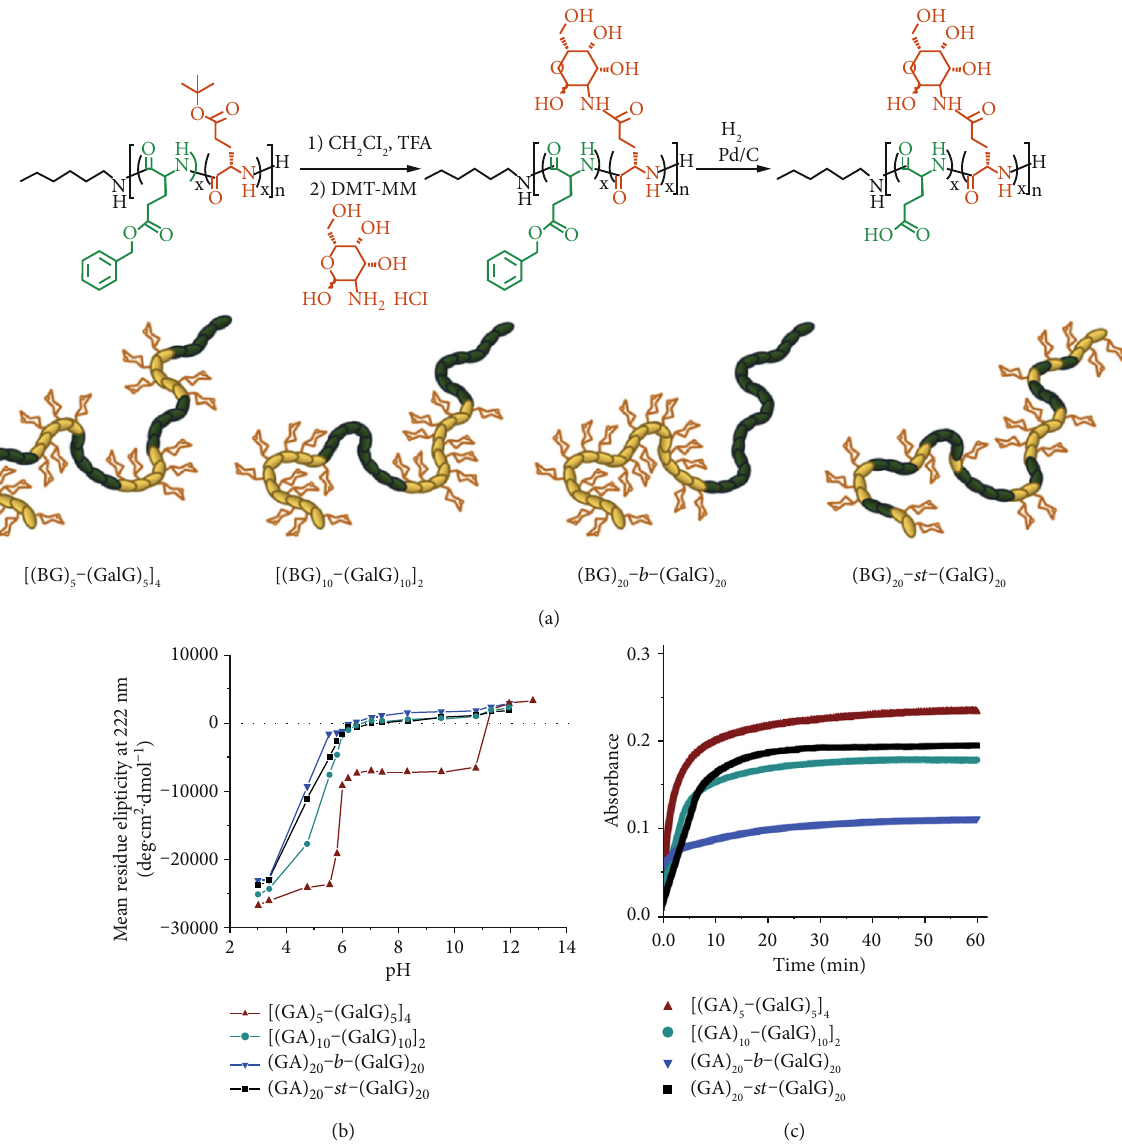
Figure 7: (a) Synthesis of glycopolypeptides with systematically varied de fi ned primary structure. (b) Mean residue ellipticity at 222 nm vs. pH of block sequence-de fi ned glycopolypeptides to show their secondary structures. (c) Absorbance vs. time after adding 50 μ L of glycopolypeptides (1 mg/mL) into 500 μ L of RCA (2 mg/mL) (reprinted with permission from Ref. [86]; copyright (2017) American 120 Chemical